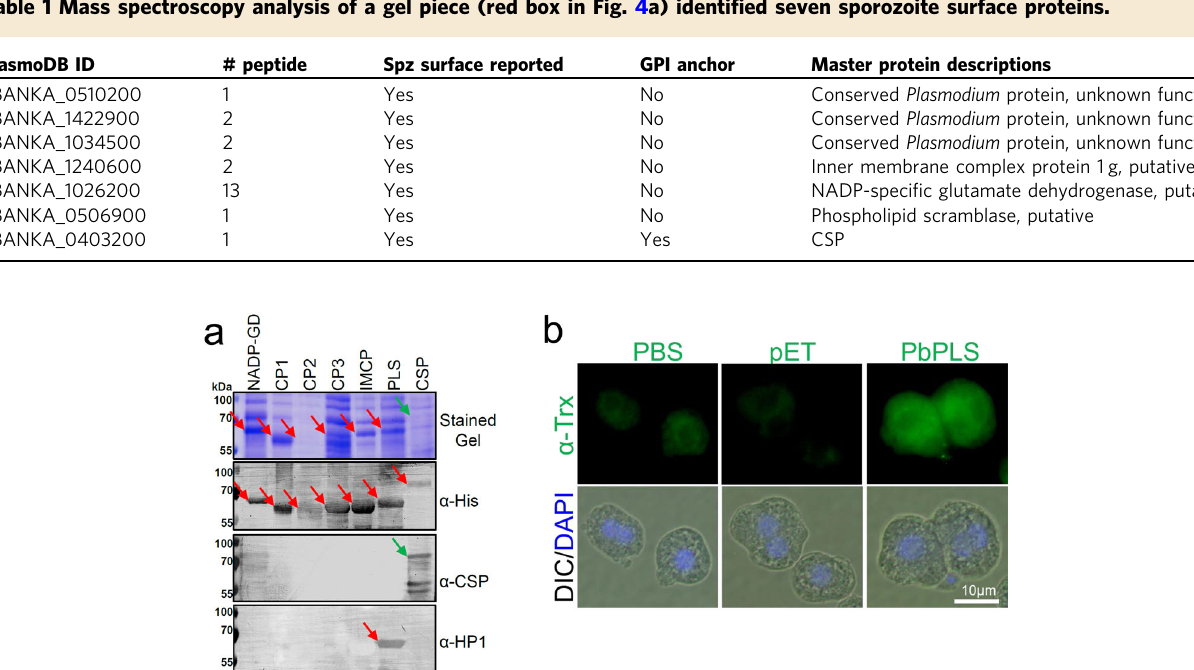
Fig. 5 The anti-HP1 antibody recognizes sporozoite scramblase. a The seven genes listed in Table 1 were expressed as recombinant proteins and fractionated by SDS – PAGE. Western blotting with an anti-His tag antibody con fi rmed expression of the recombinant proteins (red arrows) and an anti-CSP antibody con fi rmed CSP expression (green arrow). Importantly, the anti-HP1 antibody only recognized the scramblase (PLS) protein (red arrow). b the PLS protein binds to hepatocytes. Recombinant PLS, pET tag protein, or PBS were incubated with primary mouse hepatocytes. Protein binding was visualized with an anti-thioredoxin-tag antibody. a and b Each image represents two independent repeats. DIC differential interference contrast microscopy; DAPI nuclear stain (blue). Source data are provided as a Source Data fi